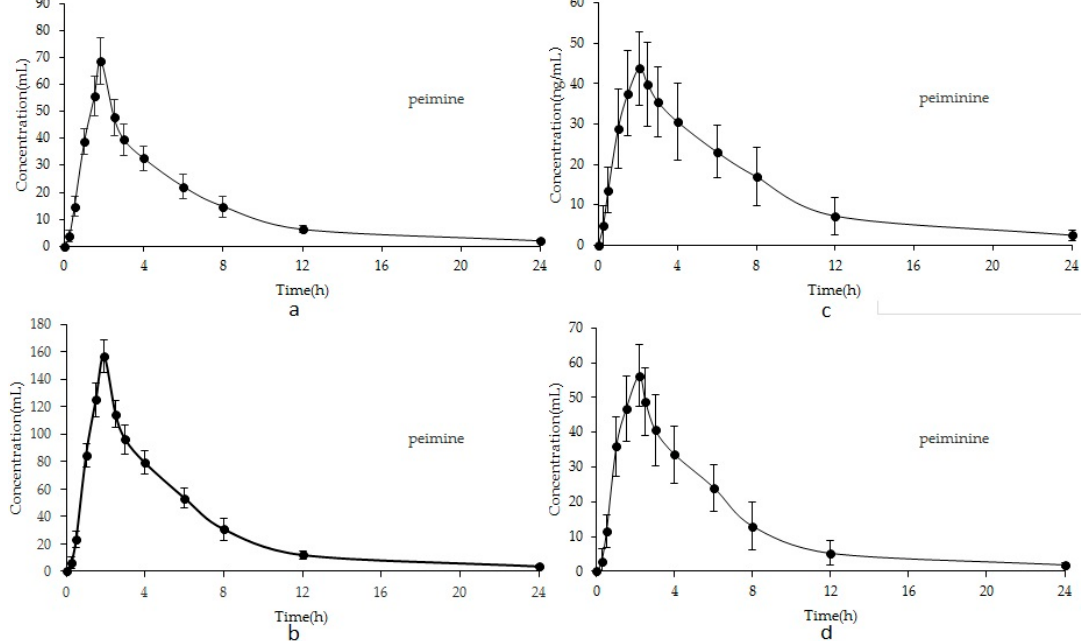
Figure 3. Mean concentration–time profiles of peimine of FU ( a ) and FT ( b ); peiminine of FU ( c ) and FT ( d ).